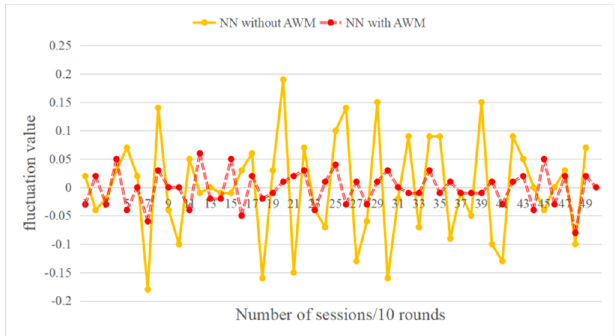
Figure 10. The comparison curve of the total score ratio. Information 2019 , 11 , 341